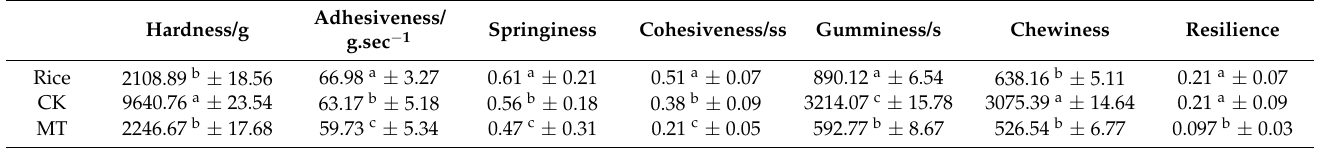
Table 7. Analysis of texture properties of adzuki